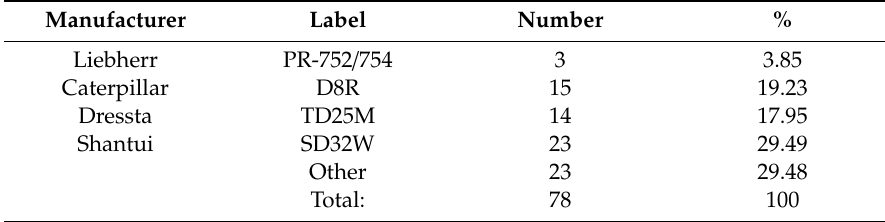
Table 1. Dozers in the Kolubara mining basin (January 2018). Manufacturer